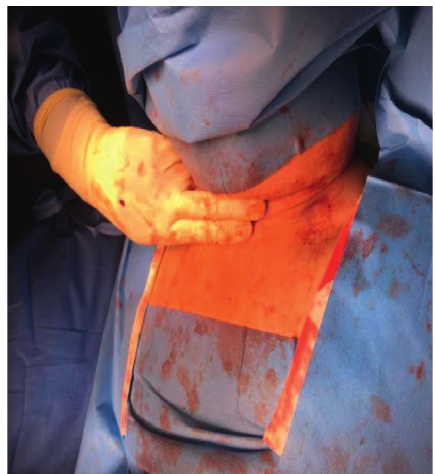
Figure 3: The patient’s short neck as indicated by the span of < 2 fingerbreadths.